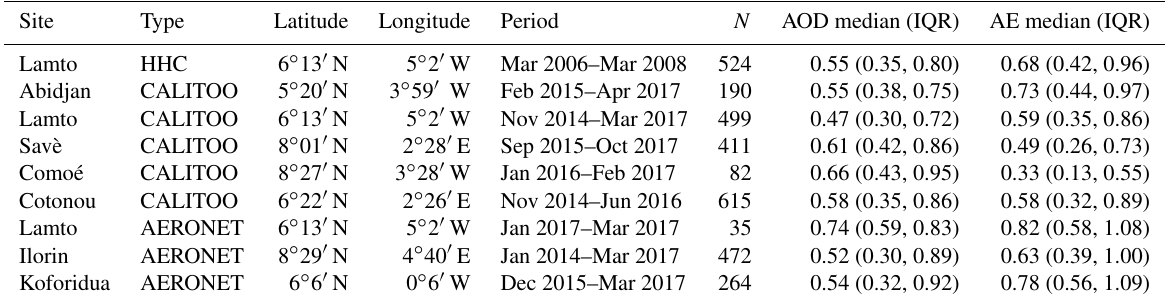
Figure 1. Map of southern West Africa (SWA) indicating the geographical locations of the sun photometer sites (red triangles) and the location and population of urban areas having more than 1000 inhabitants (blue circles with legend; source https://public.opendatasoft.com/, last access: 5 February 2021). Table 1. Summary of observation period, number of days of observations ( N ) per instrument and location. Median and interquartile range (IQR) for aerosol optical depth (AOD) and Ångström exponent